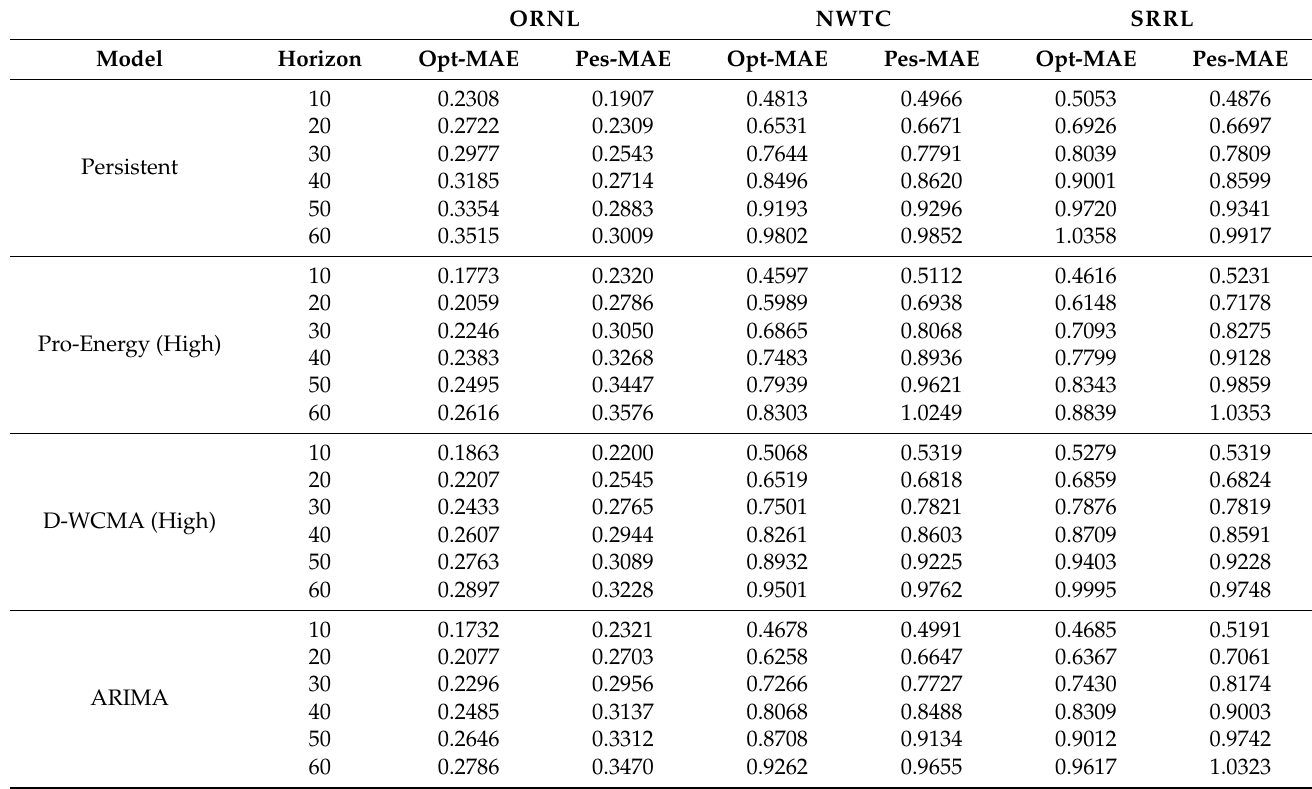
Table 2. MAE for optimistic and pessimistic predictions (in